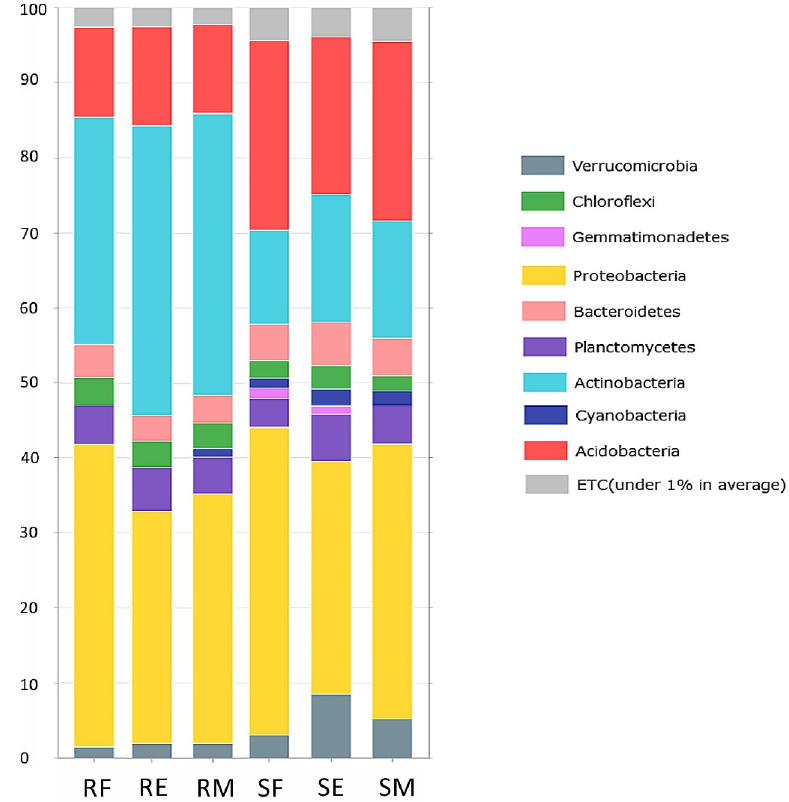
Figure 1. Average of phylum composition of obtained sequence on each sampling